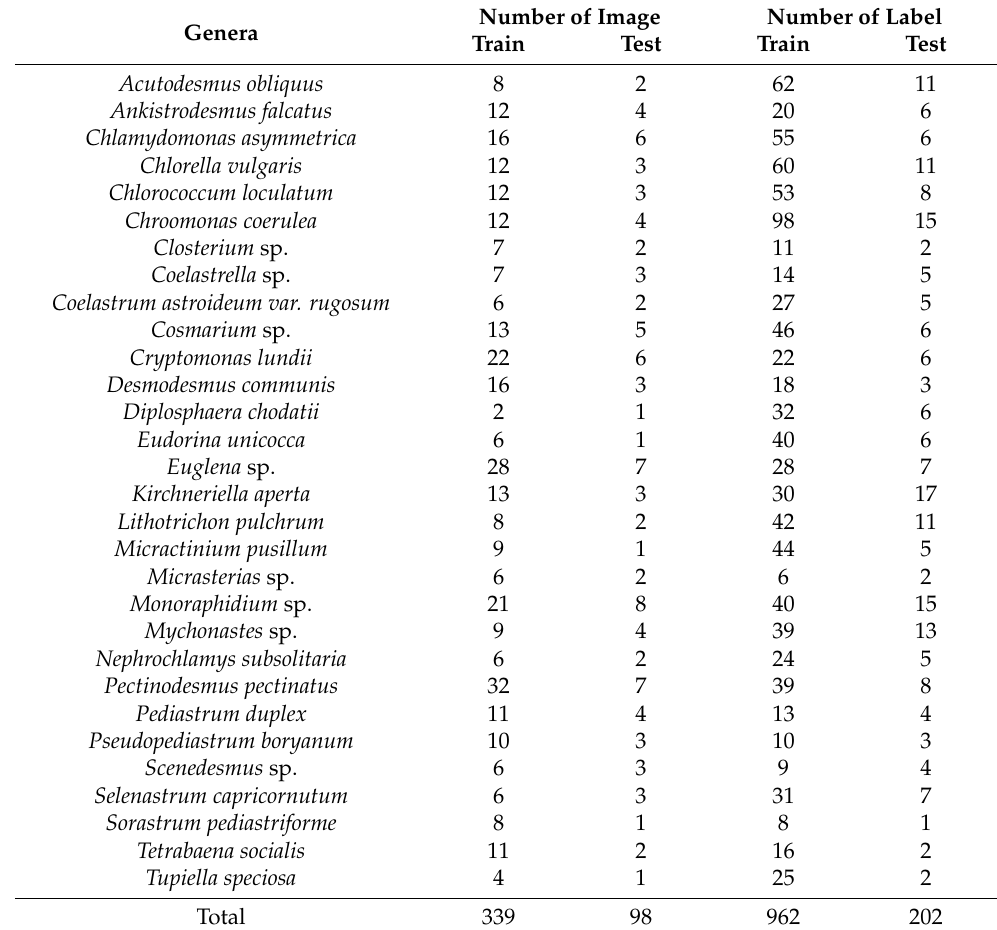
Table 2. Algal images used for model